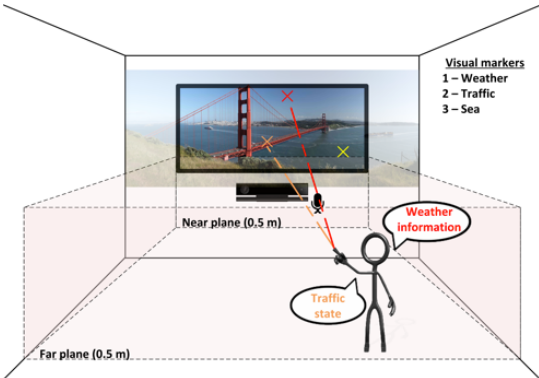
Figure 1. System